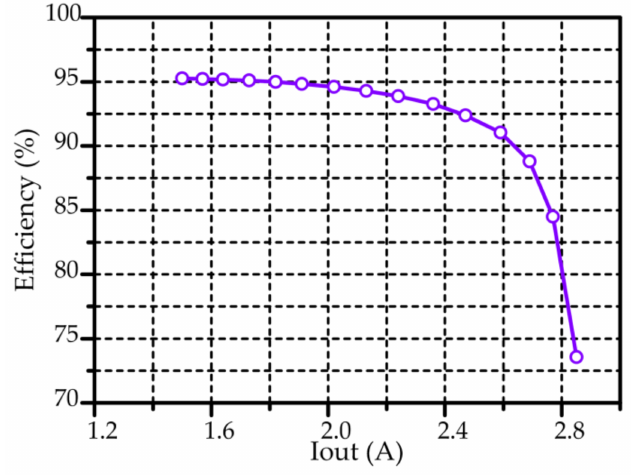
Figure 18. Variation of output power versus load current (2500 r/min).